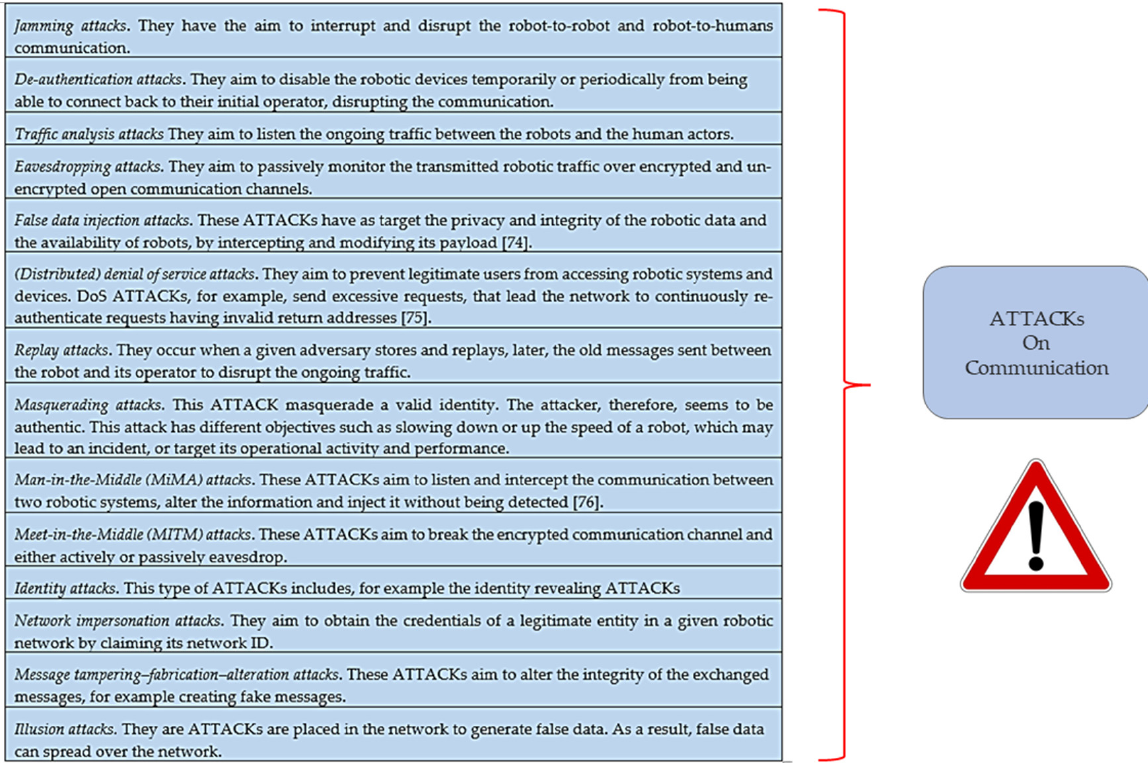
Figure 4. Examples of ATTACKs on the communication.